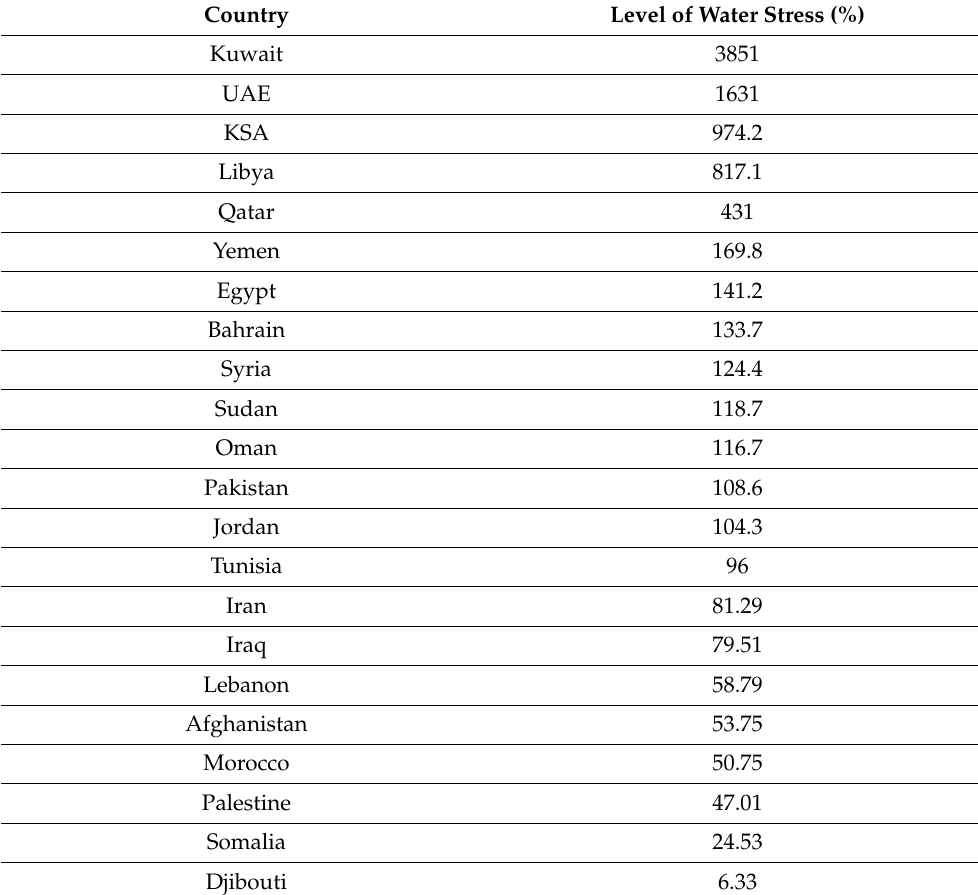
Table 1. Levels of water stress * in EMR countries in 2019 ordered from the most to least water